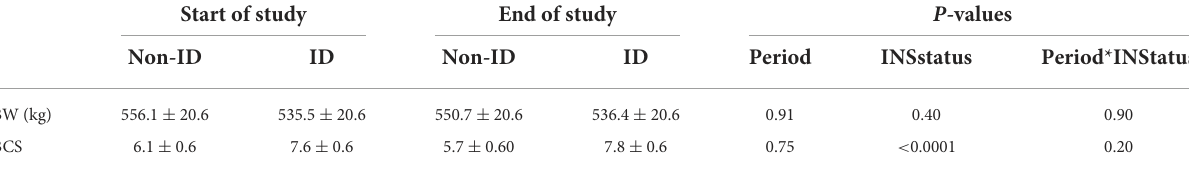
TABLE 4 Body weight and BCS at the start and end of the study in ID and non-ID